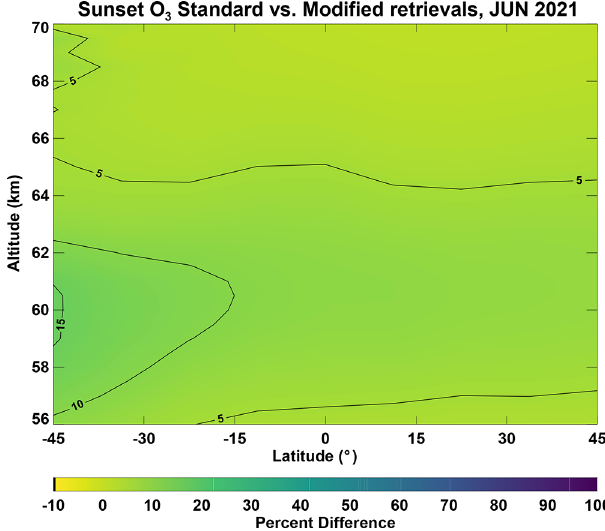
Figure 10. Latitudinal average of the percent difference in sunset O 3 between the standard (archived) retrieval and a retrieval includ- ing diurnal variations along the LOS, as a function of latitude and altitude for June 2021.